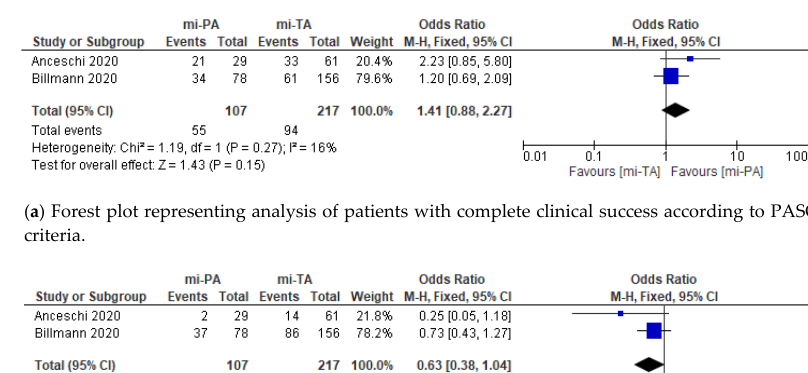
( f ) Forest plot representing analysis of complication Clavien Dindo ≥ 2. Figure 2. Cumulative analysis of eligible studies comparing mi ‐ PA vs. mi ‐ TA in terms of ( a ) operative time, ( b ) transfusion rate, ( c ) blood loss, ( d ) hospital stay, ( e ) overall complication, and ( f ) Clavien – Dindo ≥ 2. IV = inverse variance; SD = standard deviation; CI = confidence interval; M – H = Mantel – Haenszel. Each studies is represented by a square incorporating confidence intervals